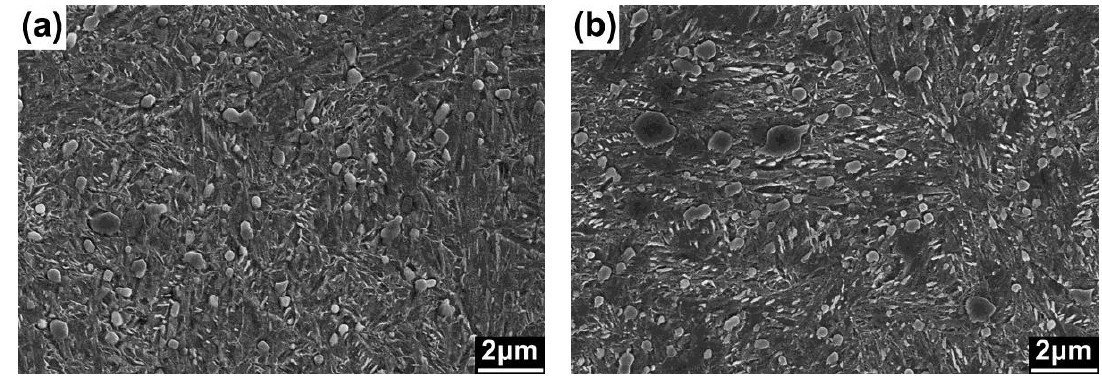
Figure 3. SEM images of the tempered specimens: ( a ) Cr6C9 and ( b ) STD11.